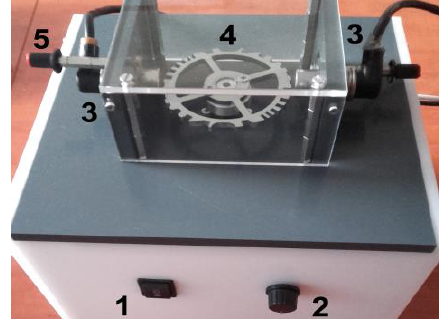
Fig. 1. A view of the prepared stand with marked components: 1 - power and rotation direction change switch, 2 - speed potentiometer, 3 - inductive rotational speed sensors, 4 - rotating ferromagnetic disk, 5 - sensor position